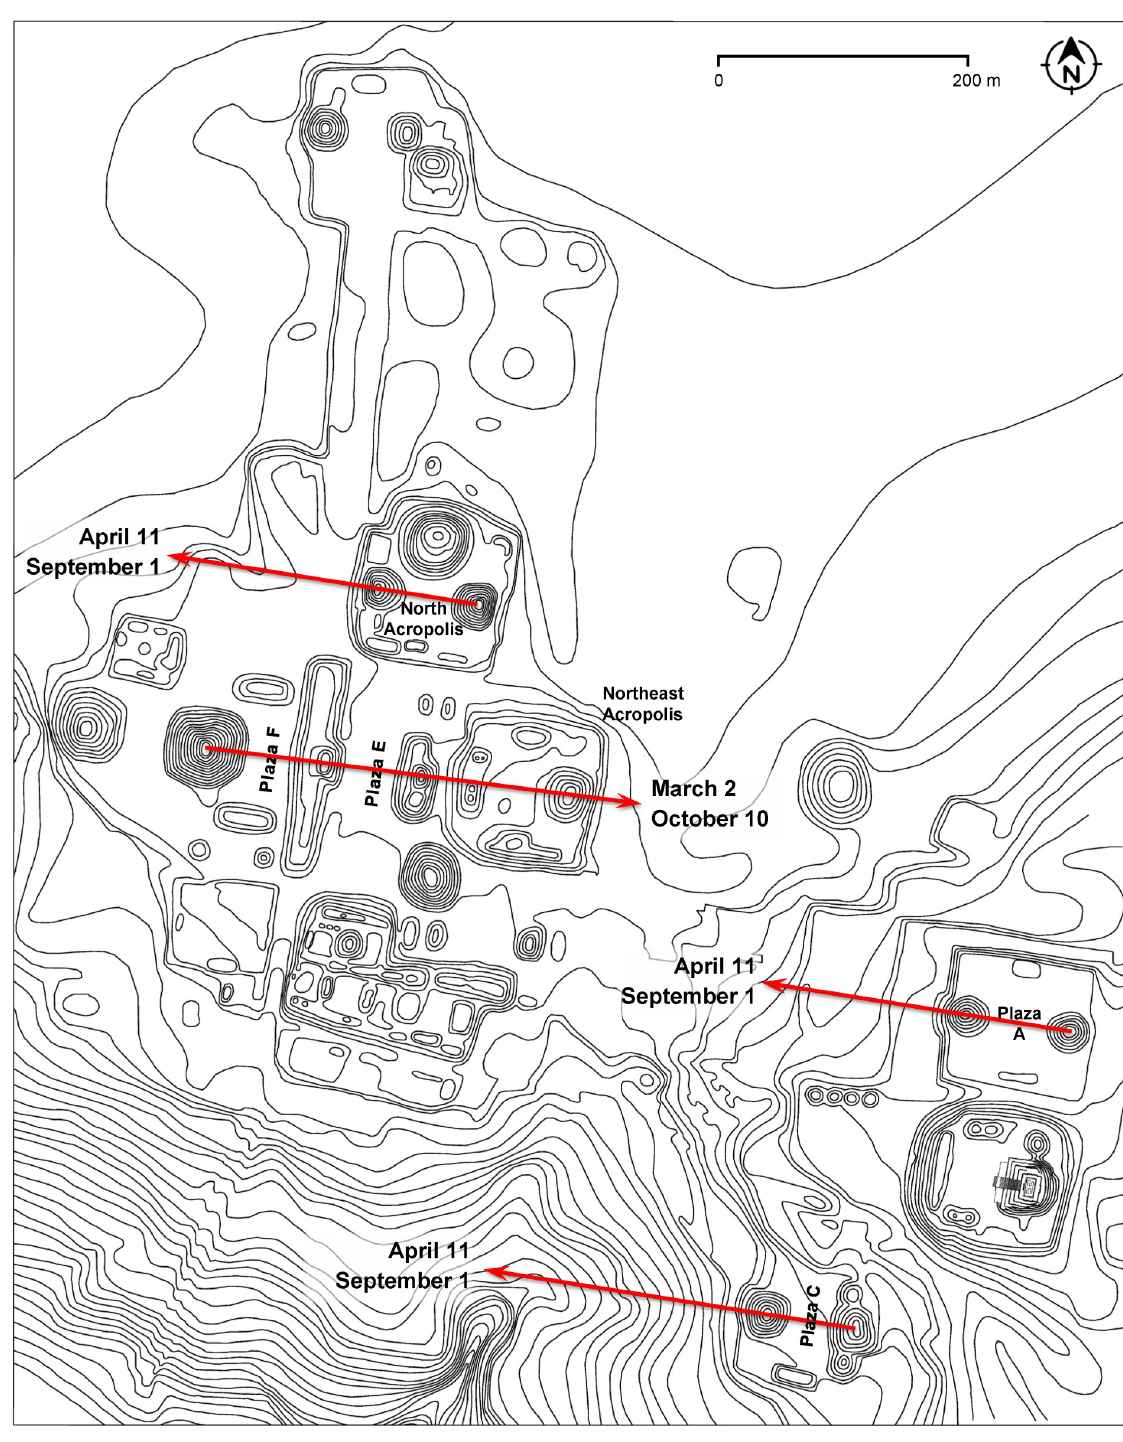
Fig 12. Map of Yaxha´ (redrawn from [98]), with alignments discussed in the text.